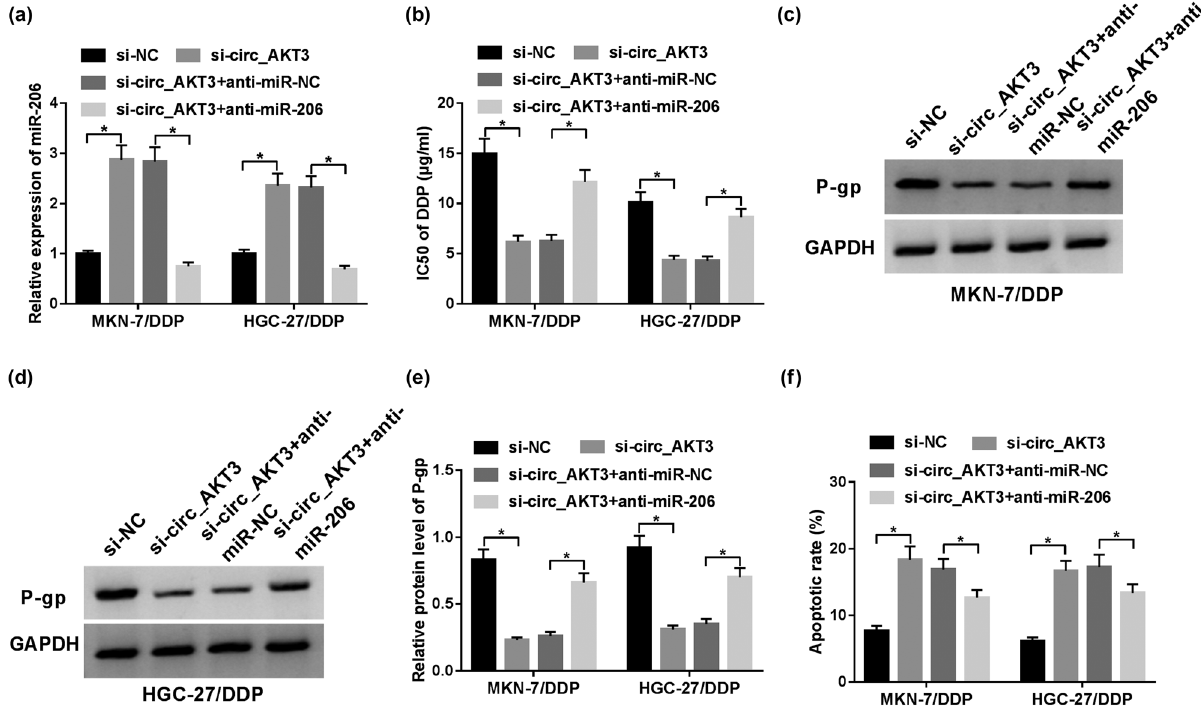
Figure 5: Down - regulation of miR - 206 attenuates the e ff ect of circ_AKT3 knockdown on cisplatin resistance of resistant GC cells. MKN - 7/ DDP and HGC - 27/DDP cells were transfected with si - NC, si - circ_AKT3, si - circ_AKT3 + anti - miR - NC or anti - miR - 206. Then, miR - 206 level ( a ) , IC 50 of cisplatin ( b ) , P - gp protein level ( c – e ) and apoptotic rate ( f ) were investigated by RT - qPCR, MTT, Western blot and fl ow cytometry, respectively. * P <